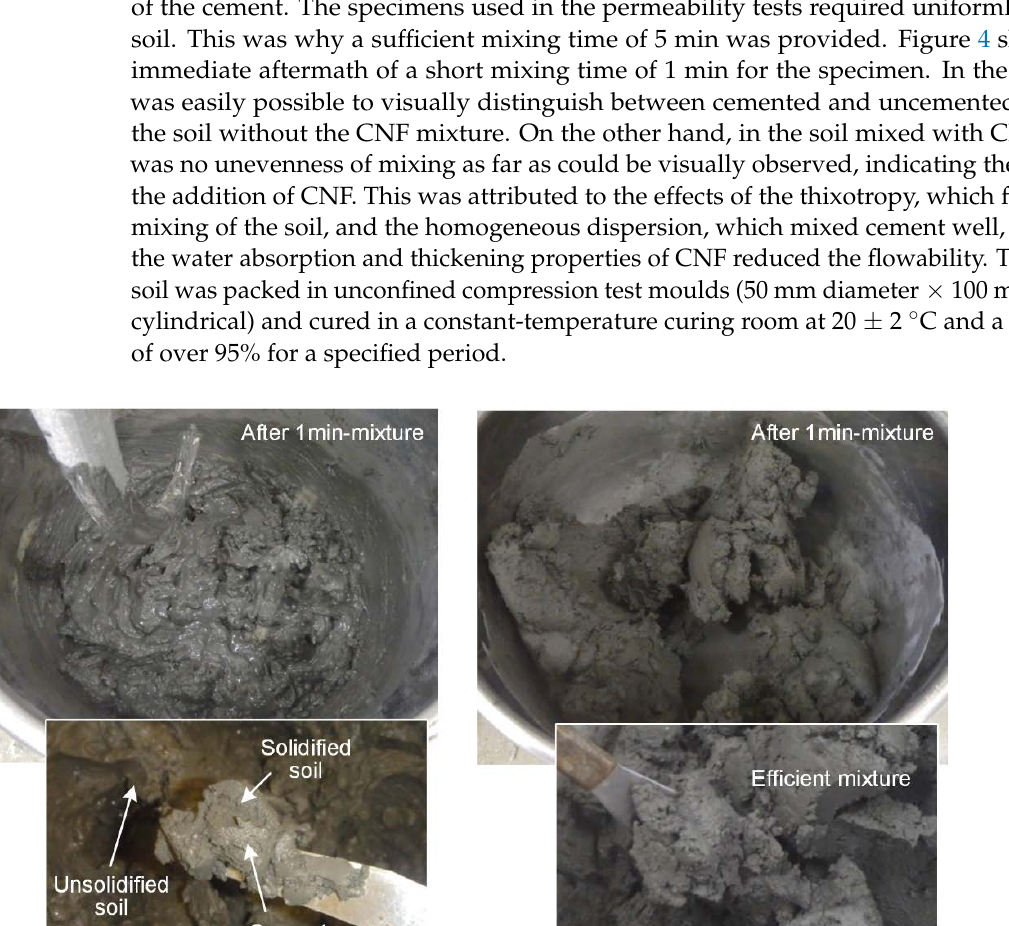
Figure 3. Mixture procedure for preparing specimens (Method 2).